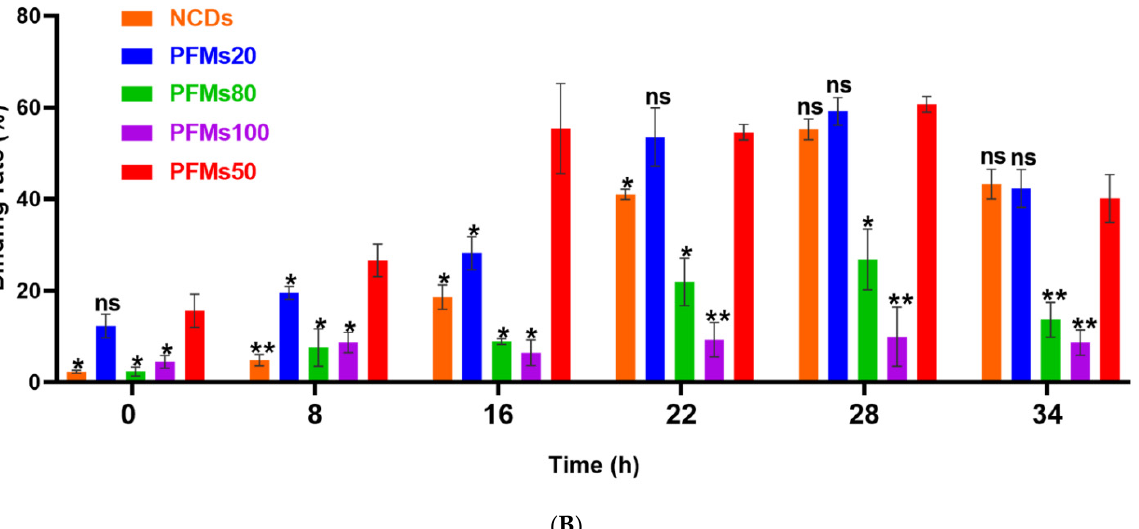
Figure 4. Permeability of P. falciparum -infected erythrocytes depends on intra erythrocytic develop- ment of Plasmodium and the size of nanomaterials. ( A ) The iRBCs at 28 h after synchronizations were stained with five different nanomaterials, respectively, gating was done according to RBCs. TO as a positive control. ( B ) The binding rates of different size of nanomaterials with different interval cultures. The asterisks denote a significant difference from PFMs50. ** p < 0.01, * p < 0.05, ns > 0.05, ns: no significance. Table 1. The binding rate (%) of different size particles with different interval cultures of P. falcipa- rum 3D7 after synchronization.